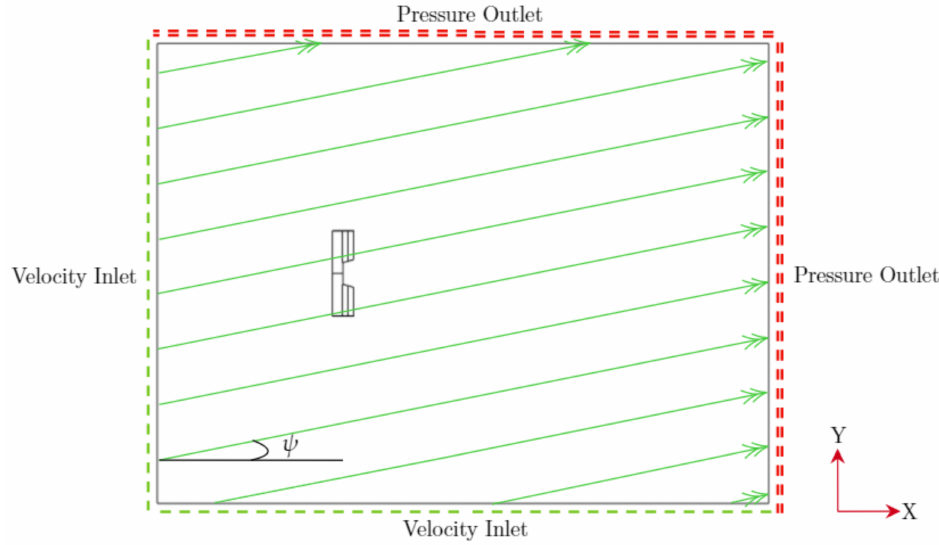
Figure 9. The boundary conditions for the fixed yaw condition where ϕ represents the yaw